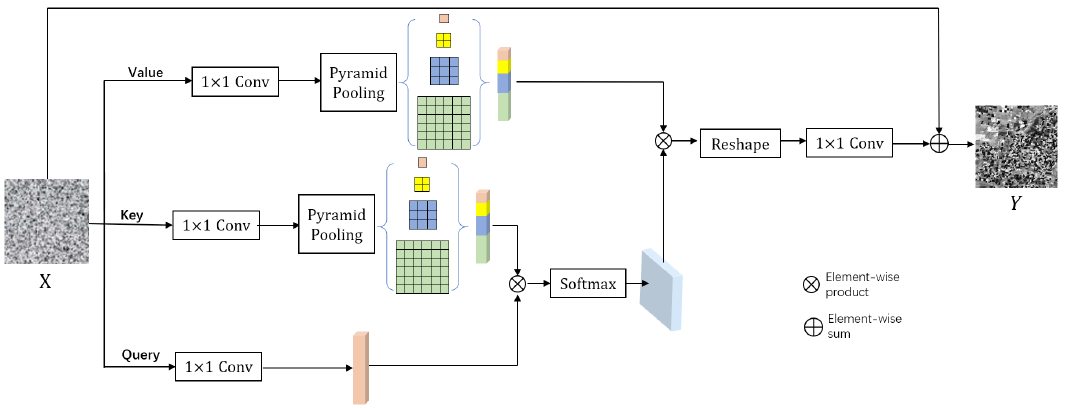
Figure 4. The architecture of APNB